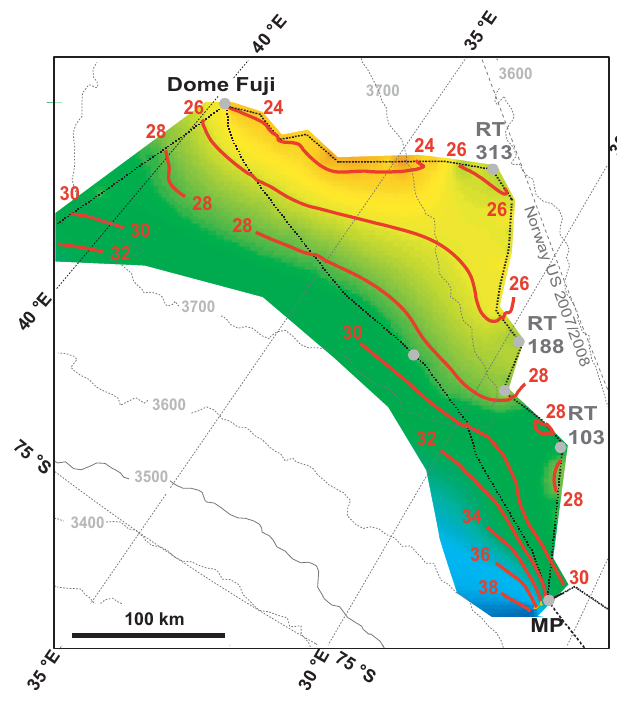
Fig. 10. Map of annual accumulation rate averaged over 722a, de- rived from the GPR data. Colour scale image with bold red con- tours and red letters shows the distribution of the accumulation rate in kgm − 2 a − 1 . Surface elevation of the ice sheet is also shown by thin gray contour lines. The purpose of this map is to visualize the large-scale spatial distribution of the accumulation rate in this area. For this purpose, the original data was smoothed over a distance of 40km to reduce fluctuations. Annual accumulation rates averaged over 749a at the NUS07-2 and NUS07-5 sites are listed in Table 3c for